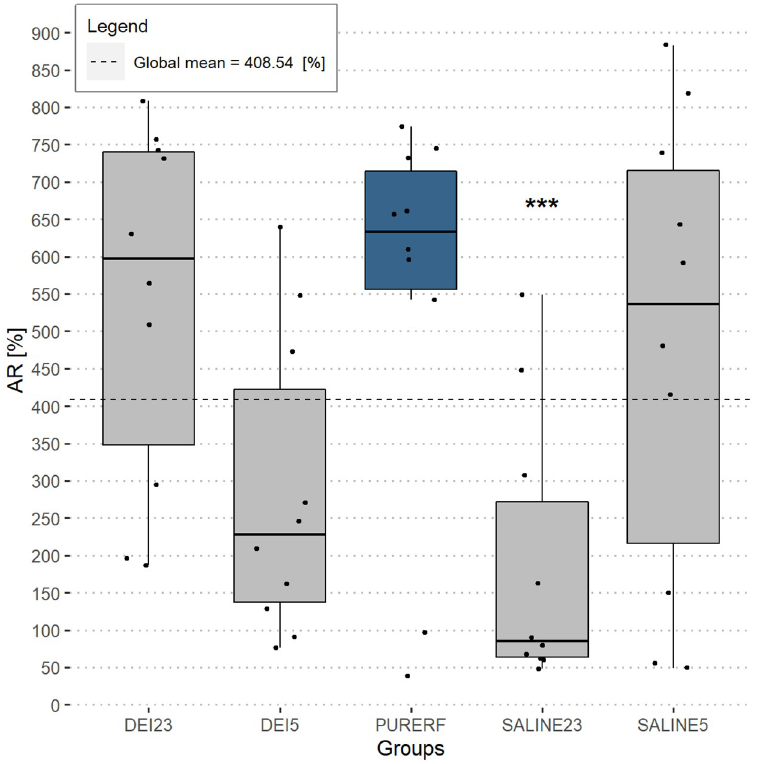
Fig 9. AR performance index. The AR index detects the variation between the minimum point of impedance to the point of occurrence of the first roll off . All experimental groups resulted in accentuated AR, except for SALINE23 with (167.7,48.4-549.4,mean,min-max,p = 0.002). Only SALINE23 showed a statistical difference, compared to the PURERF.